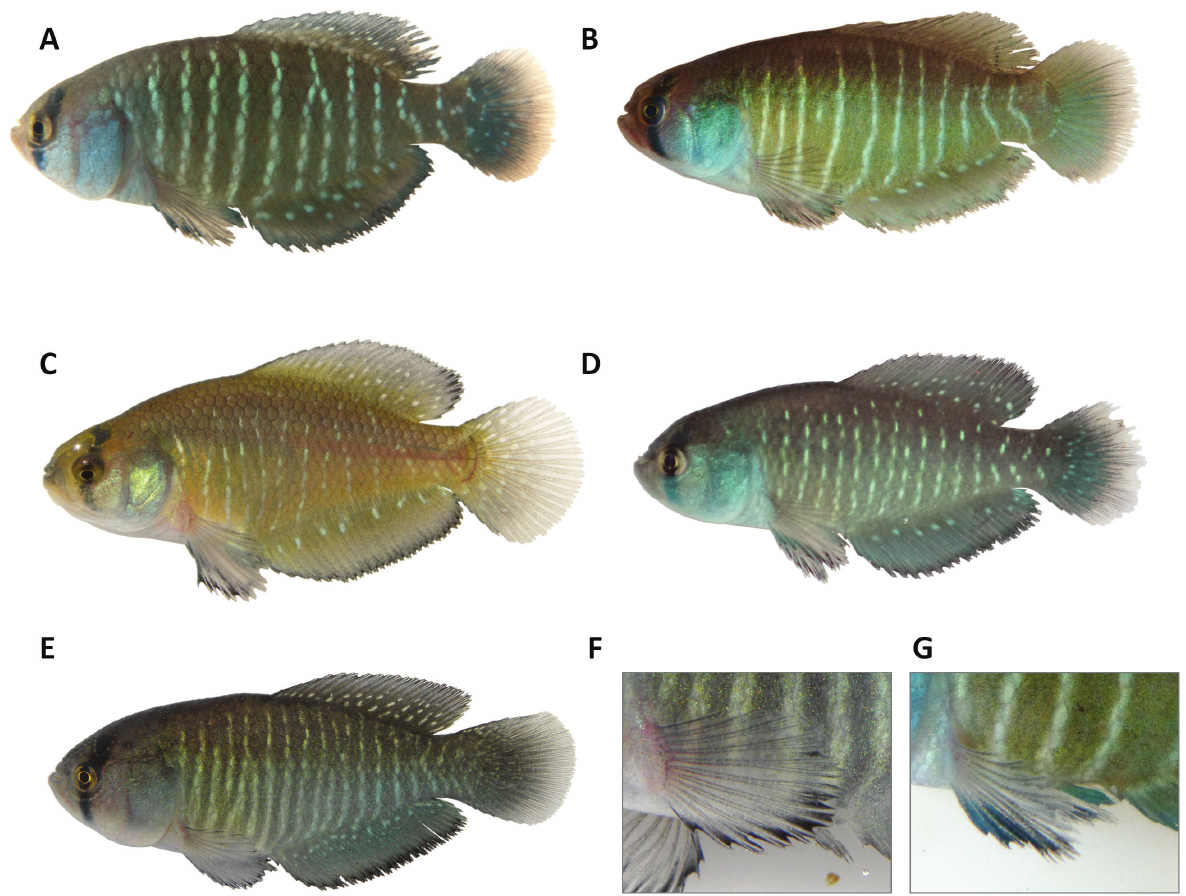
Figure 2. A. Austrolebias queguay sp. n. paratype male (ZVCP 11620); B. A. queguay non type male (32°07’26”S, 57°30’45”W), not preserved (right side, photo flipped); C . A. bellottii non preserved male; D. A. univentripinnis male (UFRGS 18064, right side photo flipped); E. A. melanoorus topotype male (ZVCP13651); F. Detail of pectoral and pelvic fins of A. melanoorus ; G. Detail of pectoral and pelvic fins of A. queguay .